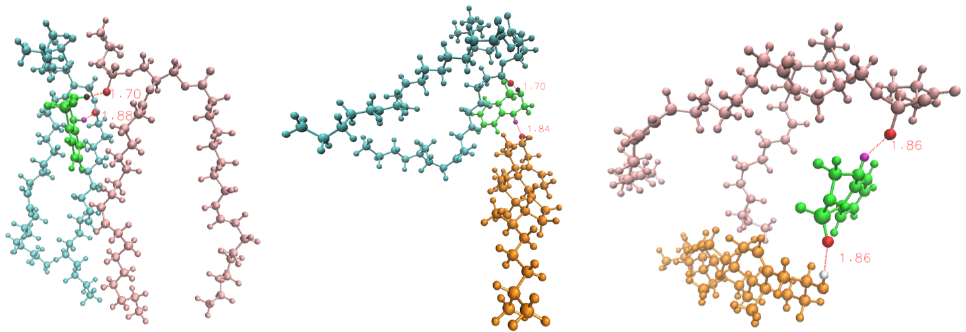
Figure 7. Snapshots of relevant configurations between benzothiadiazine derivative DBD4 (green) and their partner hydrogen-bonding sites. Lipid molecules: DOPS (pink), DOPC (cyan), cholesterol (orange). Specific sites: DBD4-H2 (black), DBD4-H4 (magenta), oxygen atoms in DBD4, DOPS, DOPC and cholesterol are depicted in red whereas hydrogen atom in cholesterol is depicted in white. Typical hydrogen-bond distances are indicated in red. This figure has been created by means of the “Visual Molecular Dynamics” package